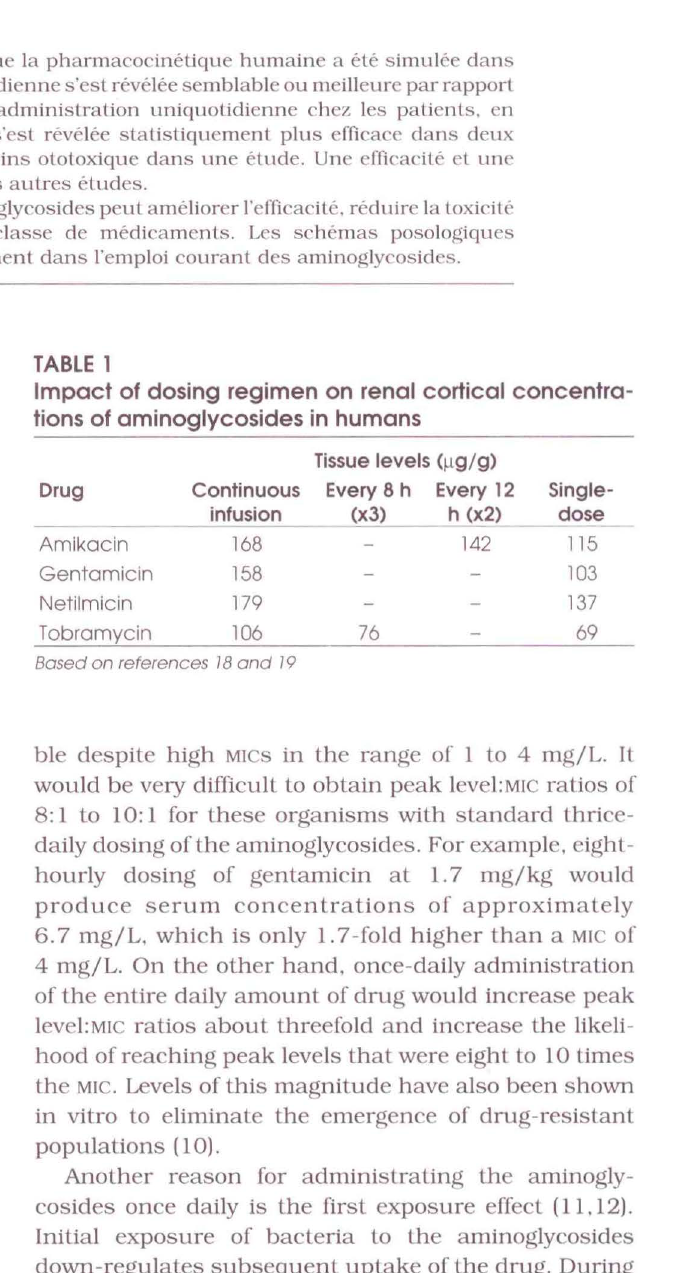
Impact of dosing regimen on renal cortical concentra tions of aminoglycosides in